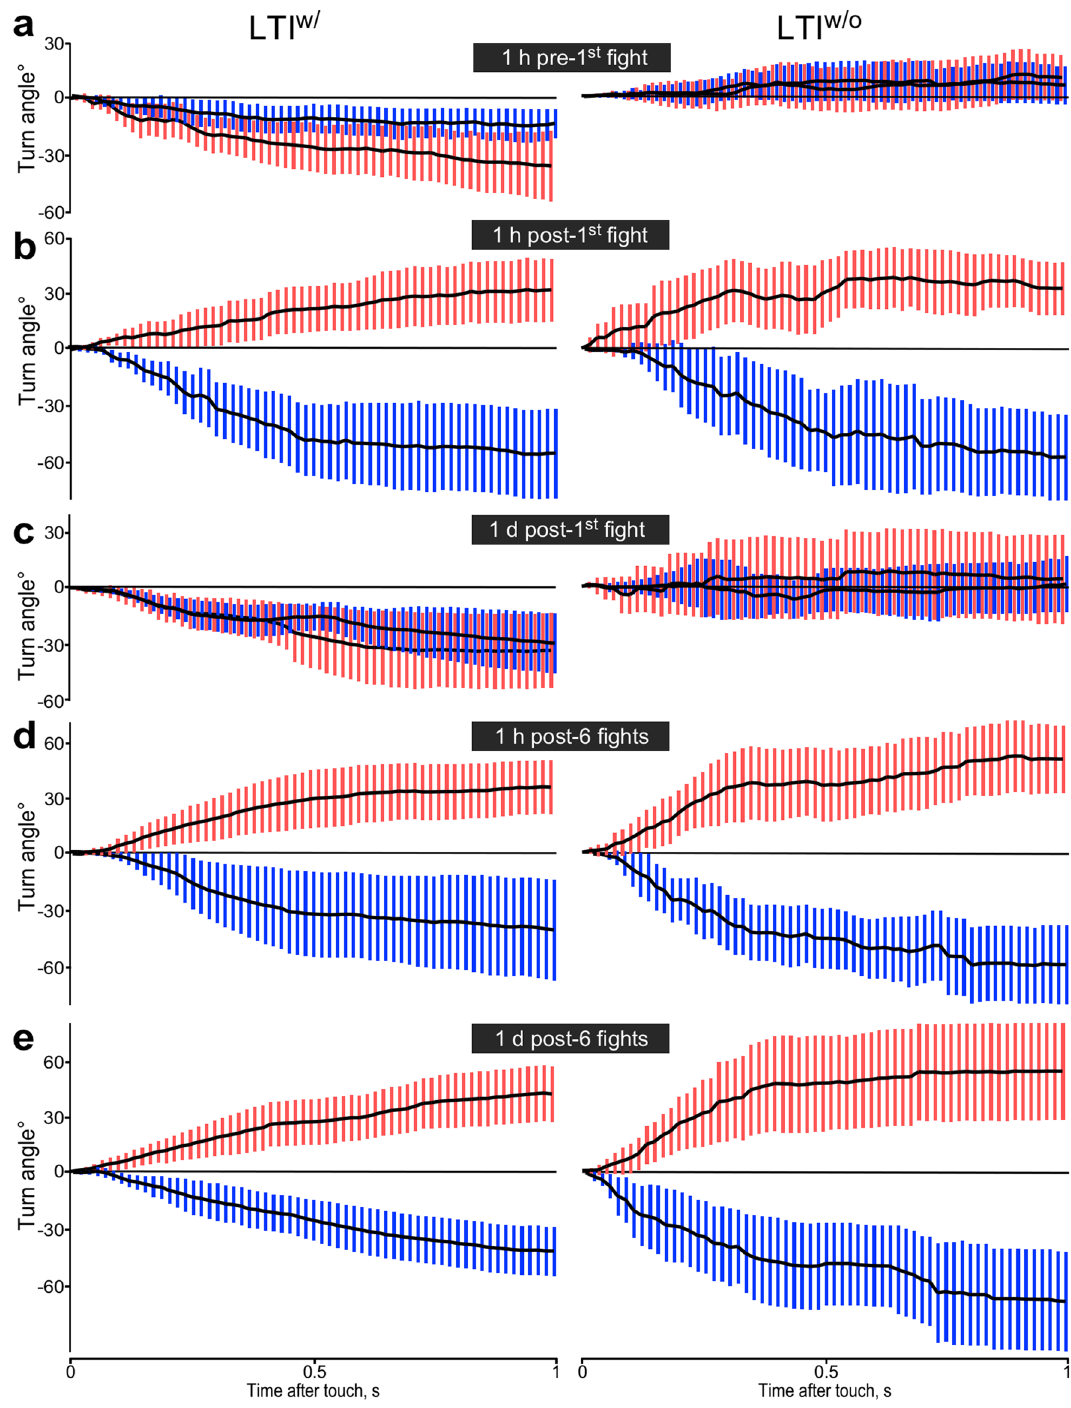
Figure 3. Turning responses of long term isolates with and without prior contact to adults (LTI w/ , LTI w/o ). Sequential plots of mean turn angles (black lines) for every frame with 95% CI. ( a ) Mature adults before fights (red and blue bars: prospective winners and losers). ( b – e ) Same animals as in ( a ) after various experiences: ( b ) 1 h after first fight, ( c ) 1 day later, ( d ) 1 h after 6 additional fights, ( e ) 1 day after the 6 fights ( n = 20 for each). All components of the figures were created with canvas DRAW 5 for MAC (Version 5.0.2, ACD Systems, https:// www. acdsy stems. com/